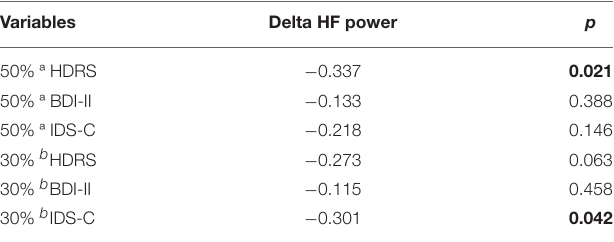
TABLE 4 | Change in HF power (Delta HF power in %) and change symptom severity of MDD before and after antidepressant treatment, correlations r pb and p -values, N =